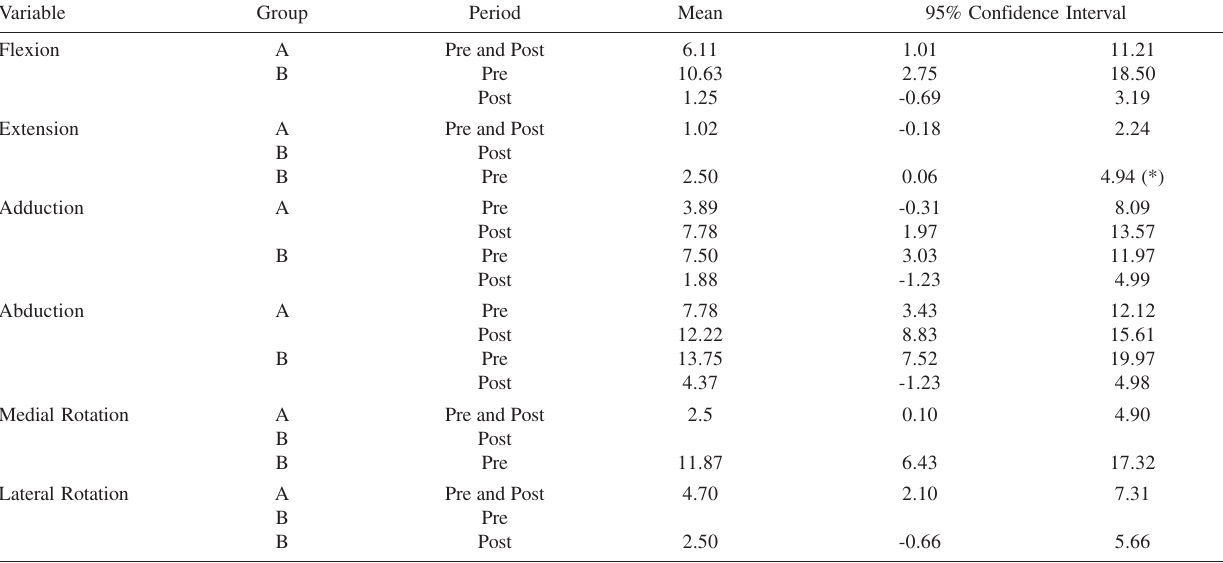
Table 3 - Mean values and 95% confidence intervals for differences between affected and nonaffected members, per group and per